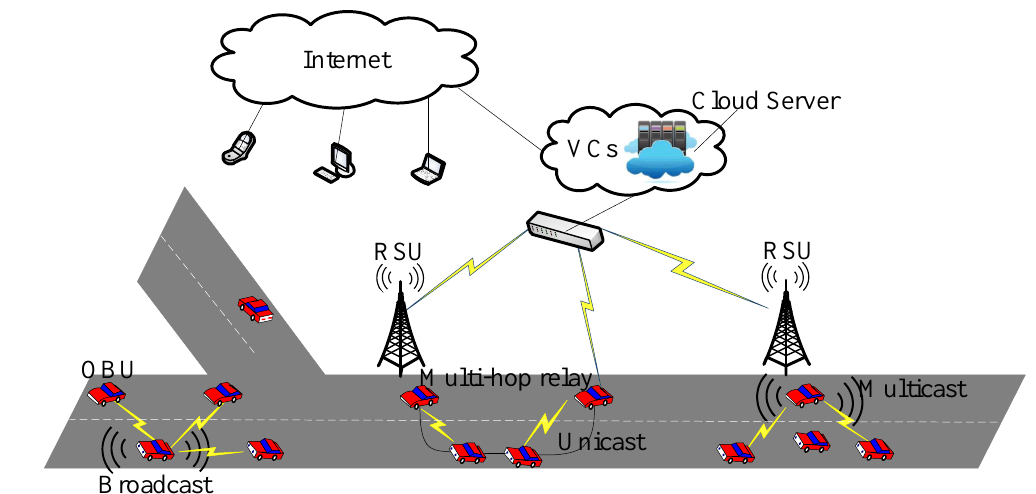
Figure 1. Network structure of VANETs.